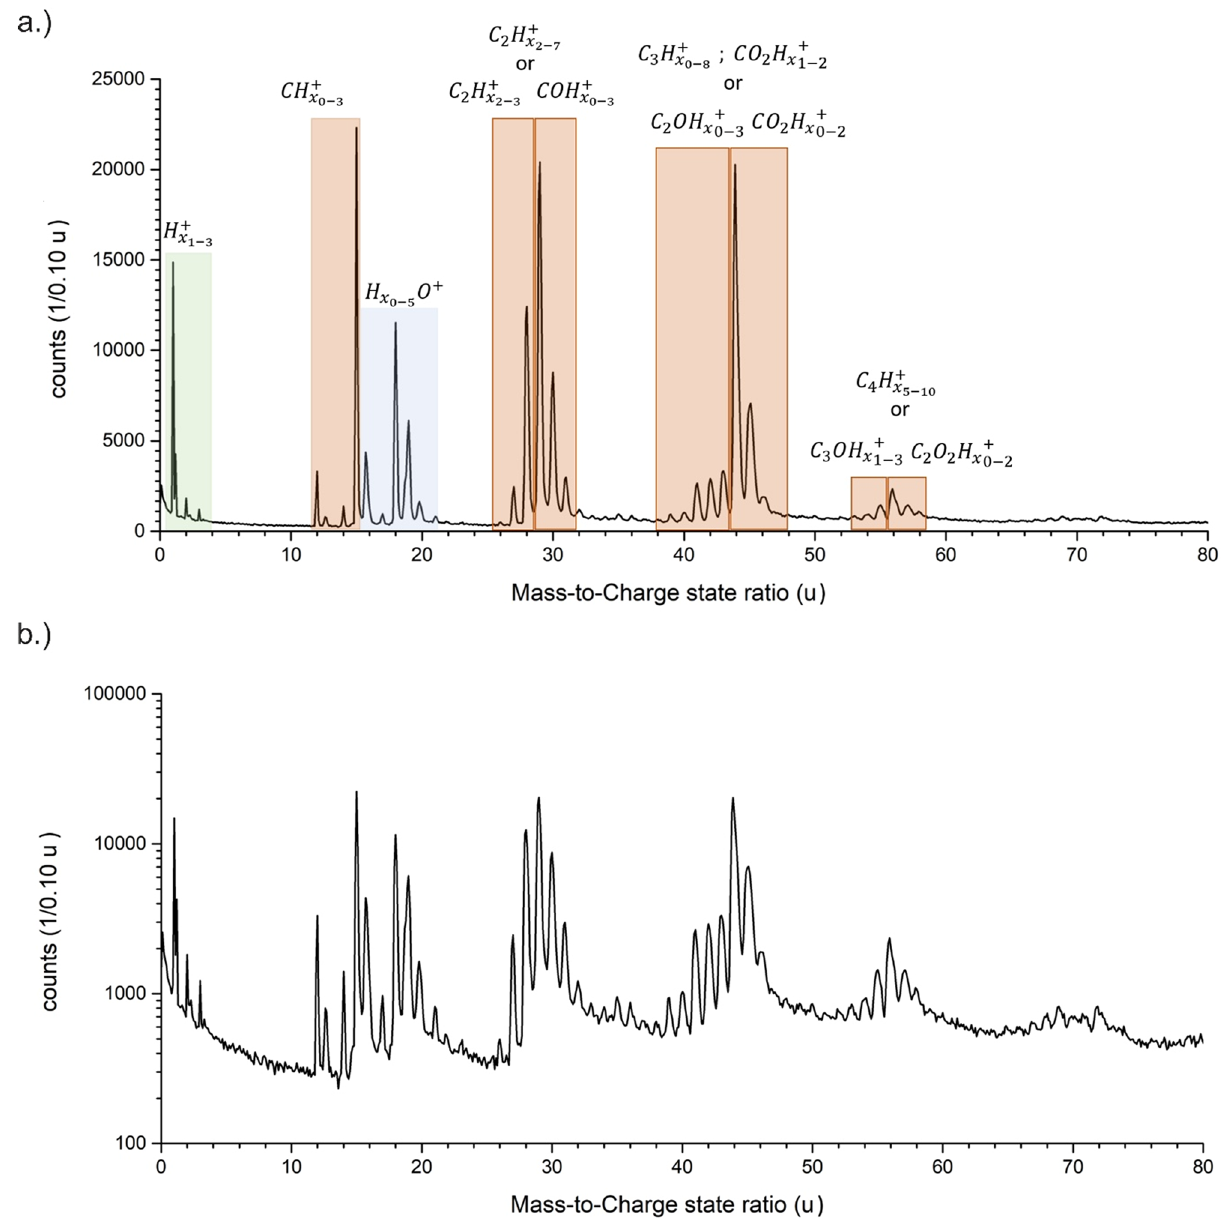
Figure 5. The mass spectra of the glucose bulk specimen. In ( a ) from the mass-to-charge state ratio of m/z = 0–80 u as linear in ( b ) from m/z = 0–80 u as logarithmic plot.